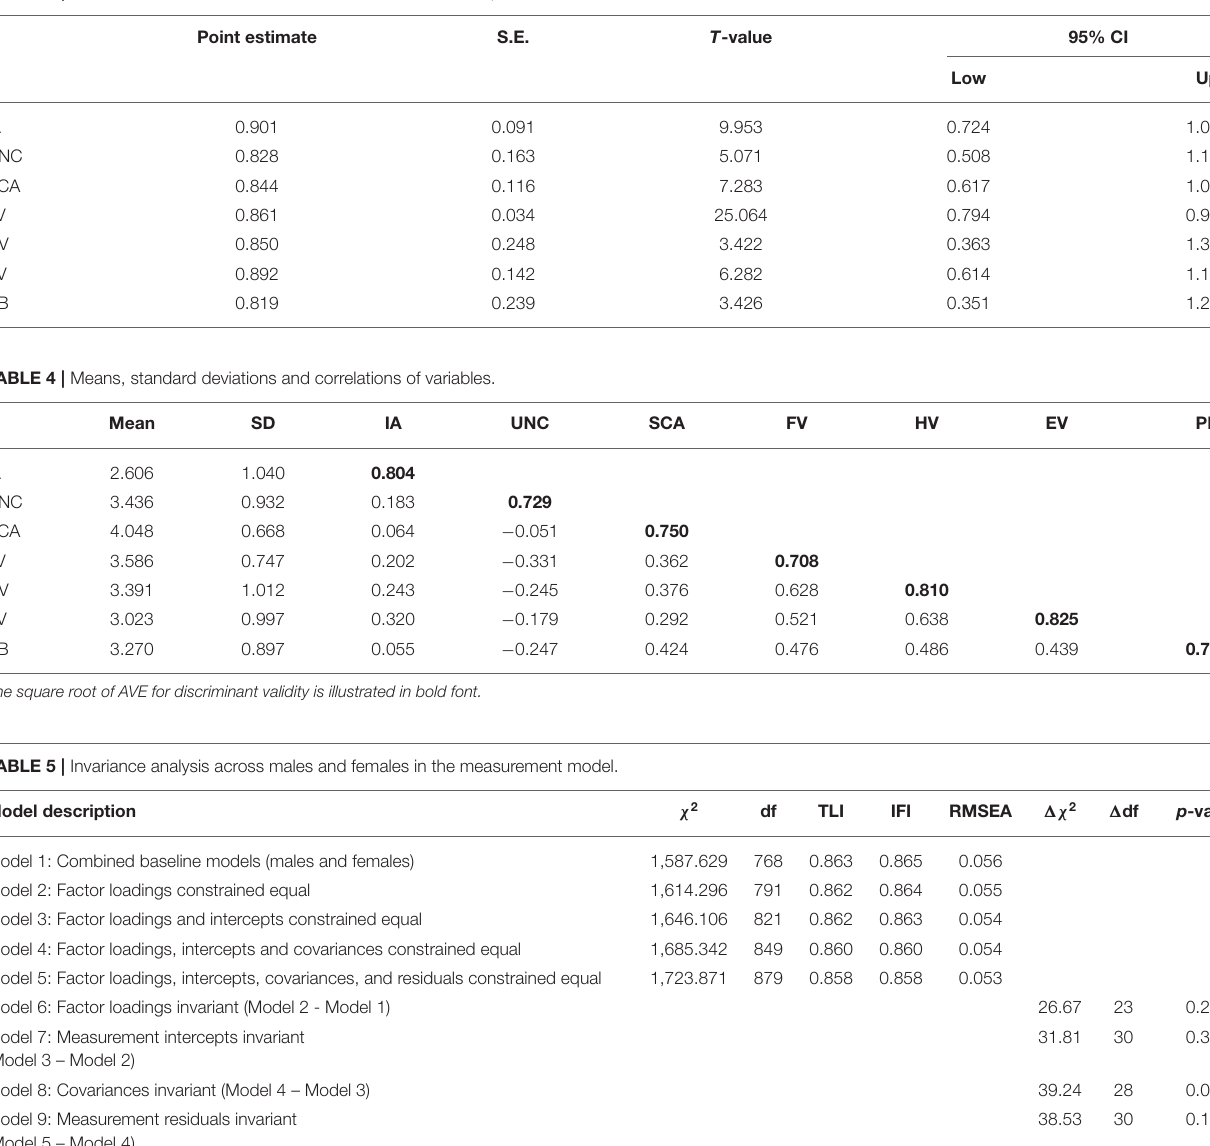
TABLE 3 | Point estimate and Confidence Interval for Cronbach’s alpha.